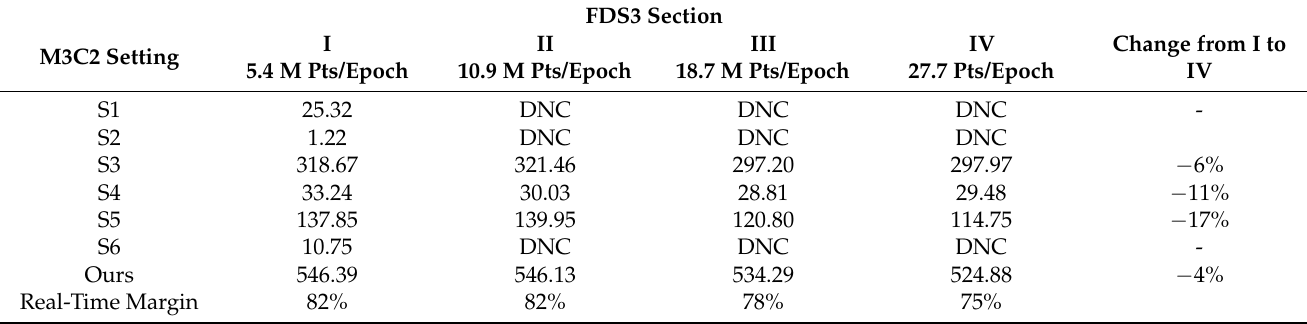
Table 5. Processing speed in points per second for M3C2 Method S1-6 and ours for FDS3 Section